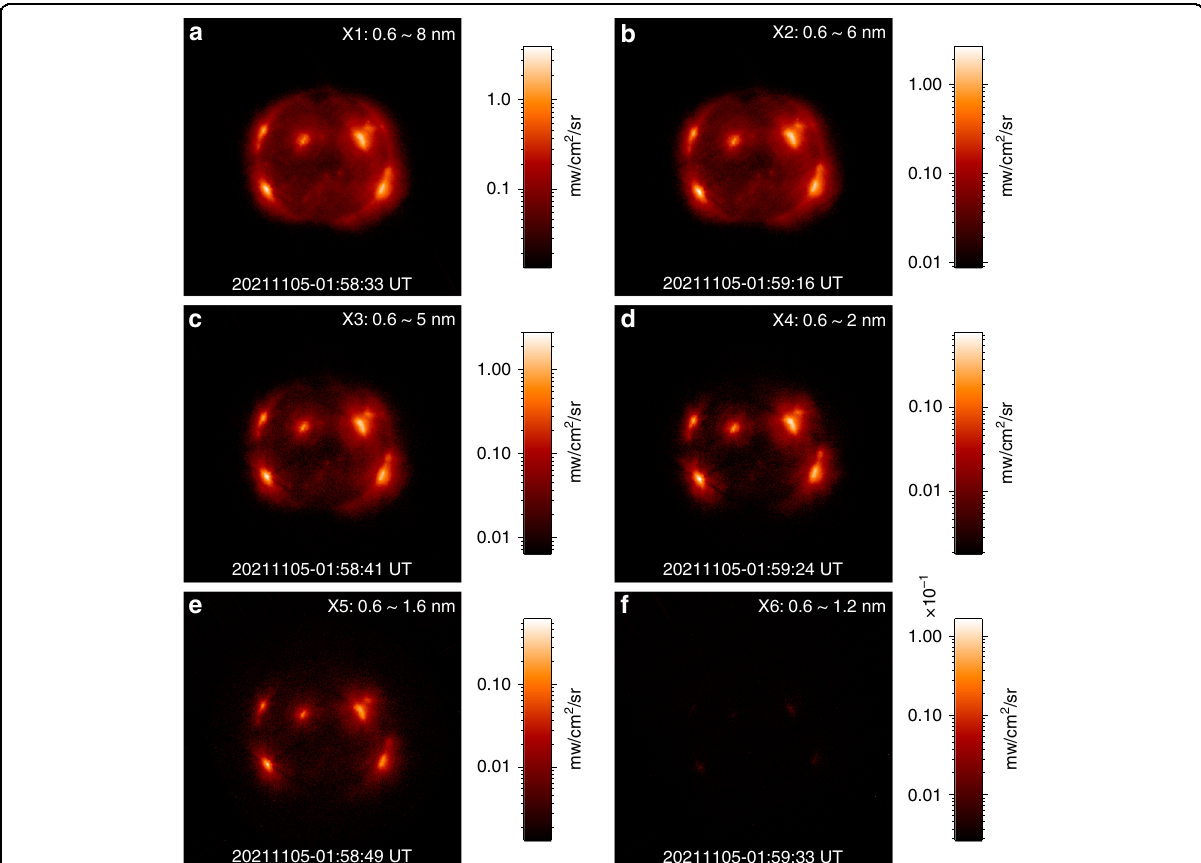
Fig. 2 X-ray images with absolute brightness from X-EUVI. The observation time is at the bottom, and the imaging channels are at the upper right corners